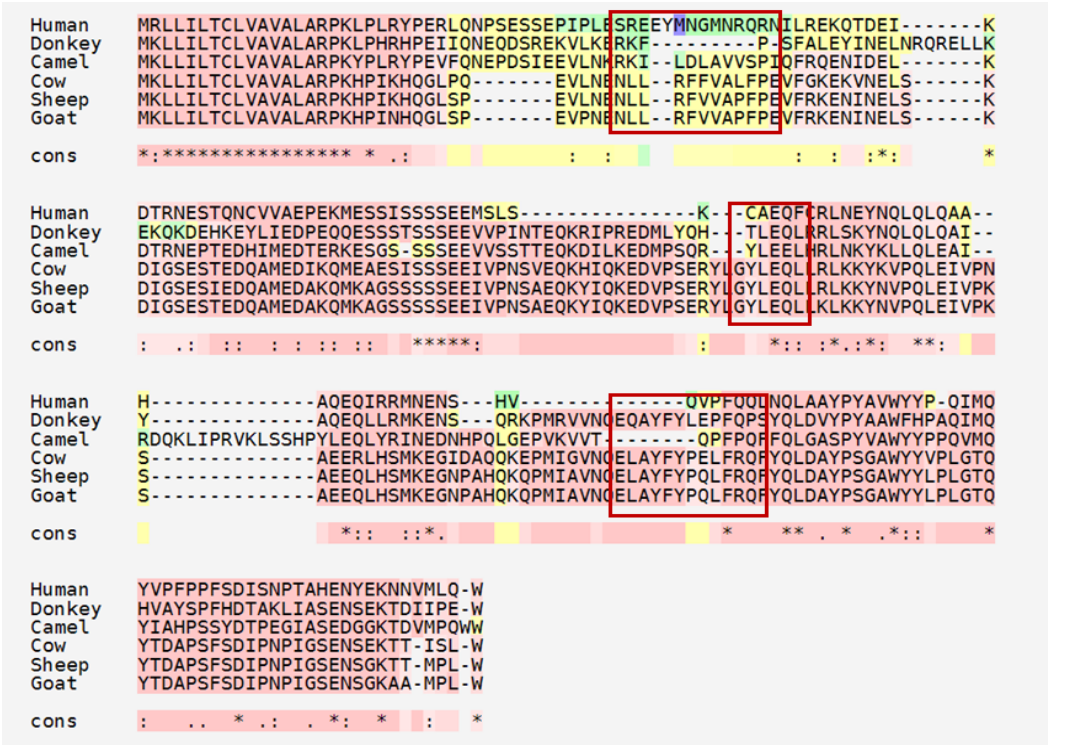
Figure 3. Sequence alignments of α s1 ‐ casein from the bovine, donkey, human, goat, and sheep milk. Sequences were obtained through the T ‐ Coffee, a multiple ‐ sequence alignment package [49]. The asterisk (*) indicates the amino acids that are conserved between sequences.